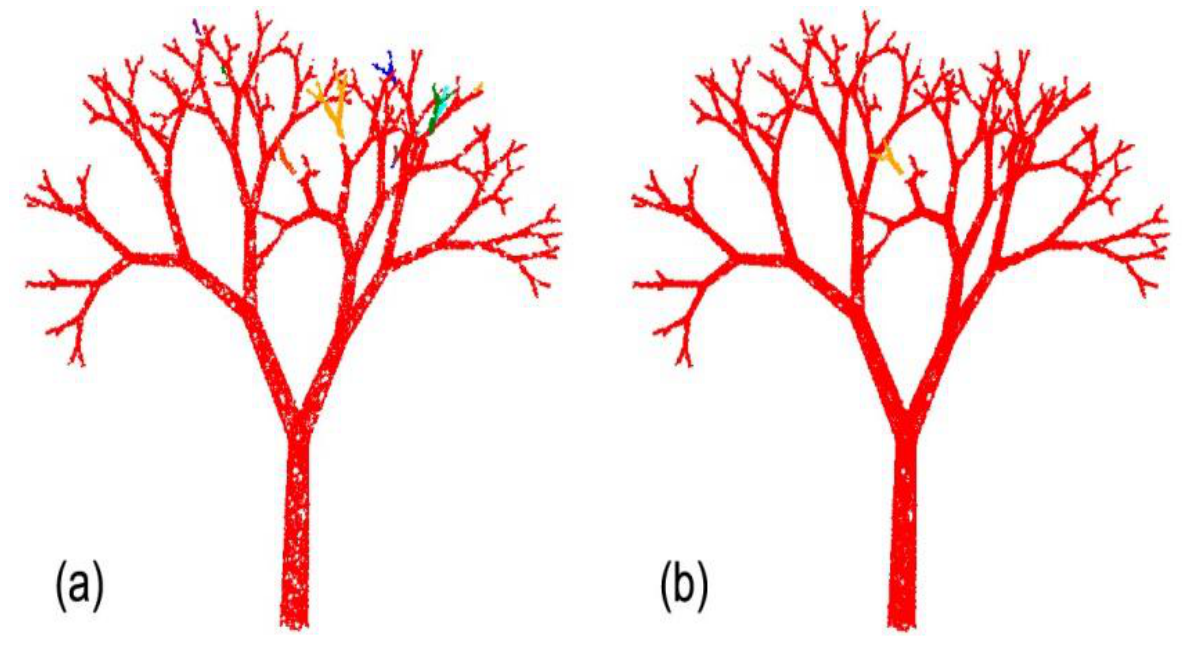
Figure 2. Effects of neighbourhood search radius r on N . Different colours refer to unconnected components ( a ) r = 0.04 (14 components); ( b ) r = 0.05 (two components) and ( c ) r = 0.06 (one